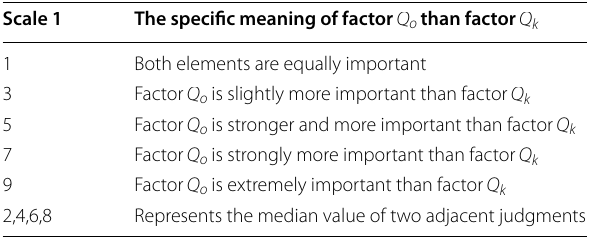
Calculation of judgment matrix at each